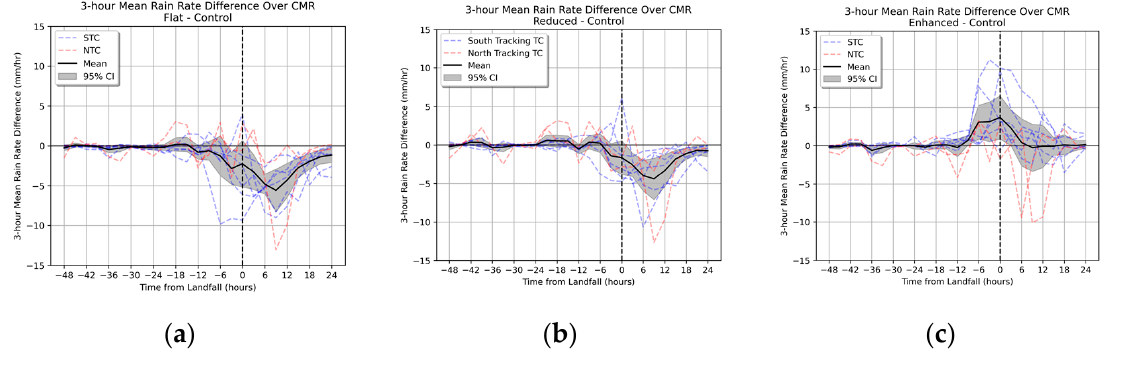
Figure 10. Similar to Figure 5, but for CMR precipitation difference for ( a ) Flat—Control, ( b ) Reduced—Control, and ( c ) Enhanced—Control.